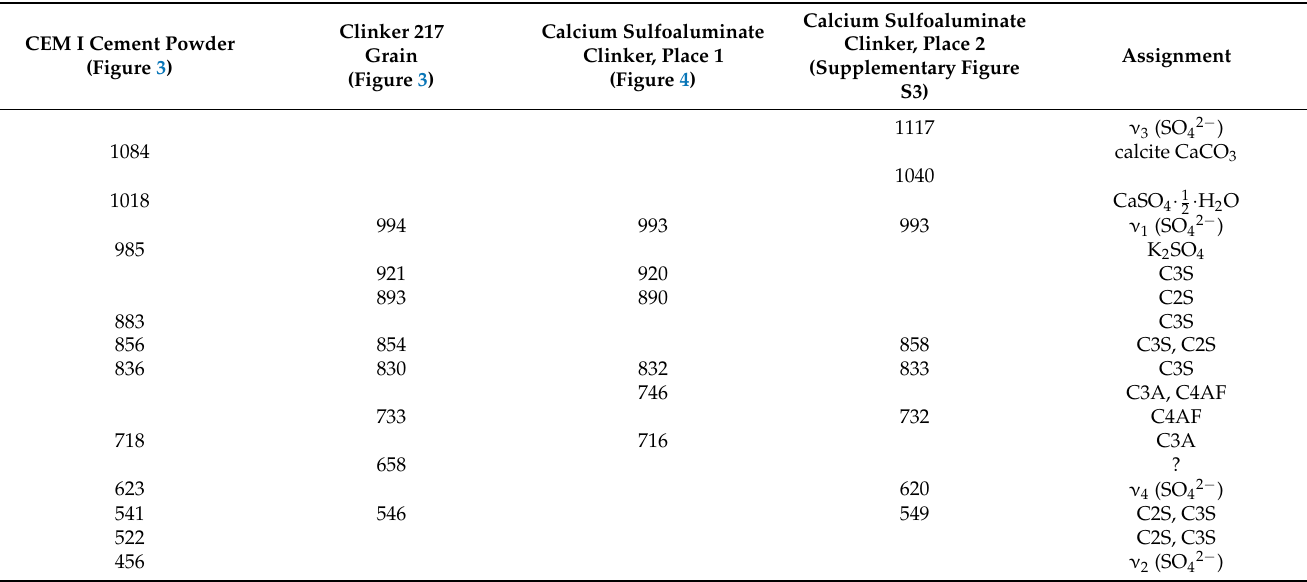
Table 4. Observed Raman bands of cement CEM I powder, clinker 217 grains, and polished calcium sulfoaluminate clinker embedded in resin together with the assignment of bands (cm − 1 ). Abbreviations: C3S—Ca 3 SiO 5 , C2S—Ca 2 SiO 4